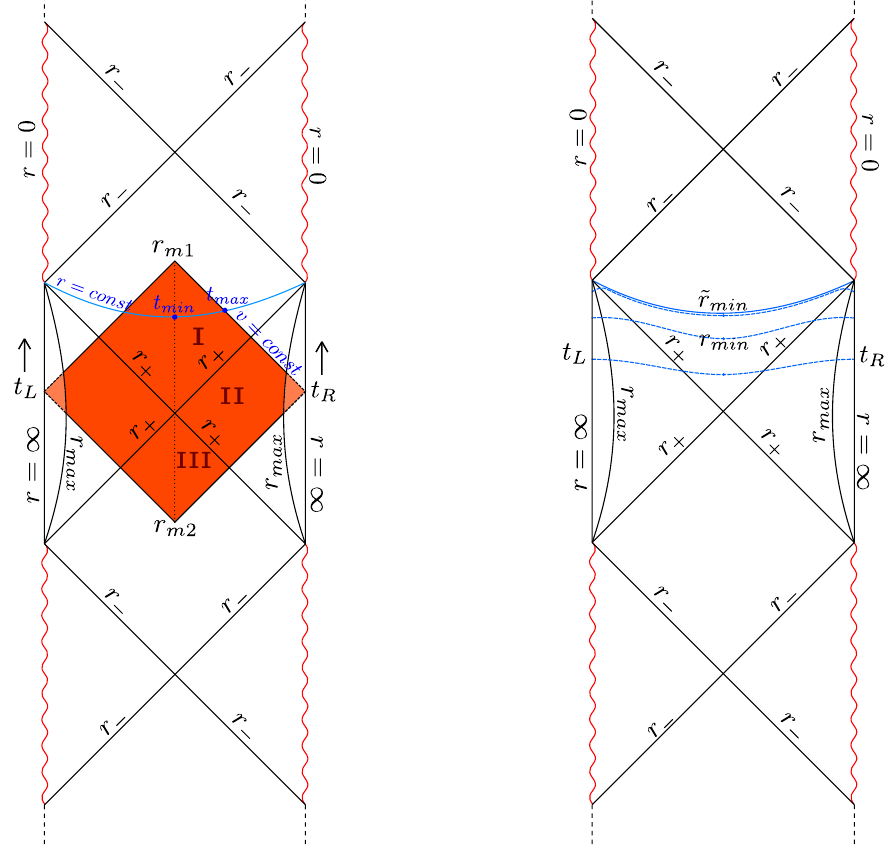
Figure 1 . Penrose diagram of rotating BTZ. Left: the WDW patch of a boundary time slice with t L = t R (see section 2.1.1 ). r max denotes the radial bulk cutoff. By symmetry t min = 0 . Right: the blue slices are the maximal ones of the CV conjecture. The minimal radius r min is defined through ˙ r | = 0 . For t b → ∞ , the maximal bulk slice is at constant r = ˜ r min . r min ( r ). Using the right-left symmetry one can focus on the right boundary and observe that m 2 the tips lie on the same constant v (respectively u ) slices as ( t b